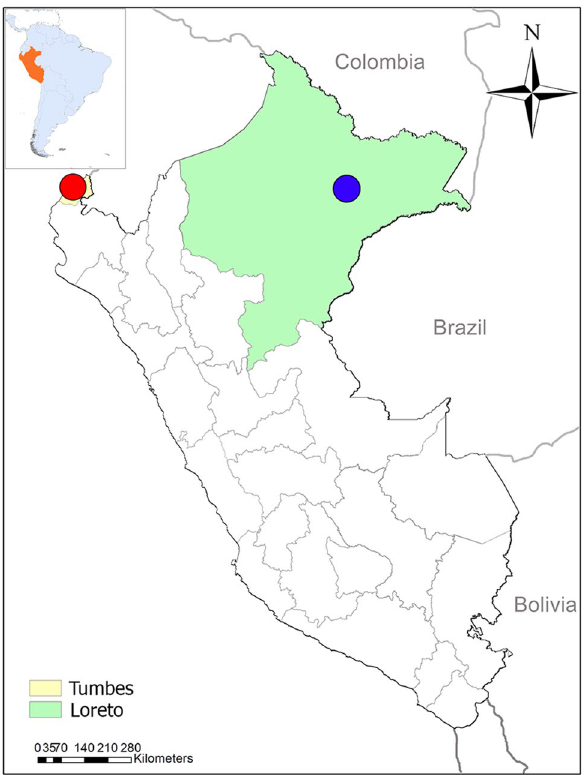
Figure 1. Collection sites. Samples for this study came from P. falciparum specimens collected in the Peruvian North Coast (red dot) and Amazon Basin (blue bot) between 2006 and 2017. The map was created using ArcGIS online (ESRI Inc. Redlands, CA, USA. https:// www. esri. com/) using open data obtained from GADM database of Global Administrative Areas, version 3.6. www. gadm.